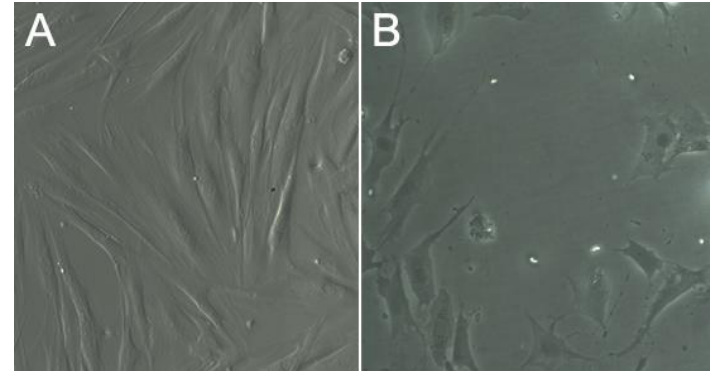
Figure 10. Optical images of fibroblast cells grown in the absence ( A ) or in the presence ( B ) of the scaffold GO sigma /CS SL 1%.